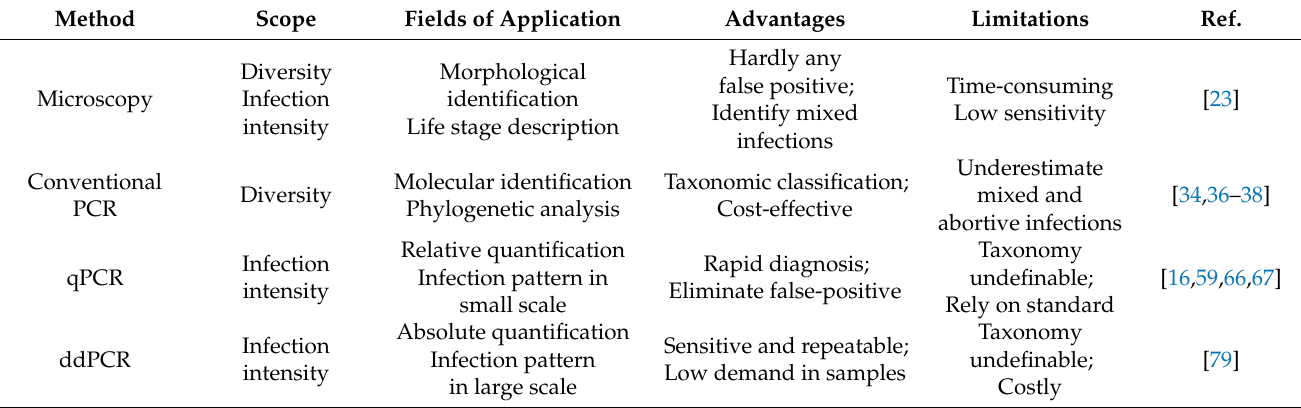
Table 2. Comparison of the most widely used methods in studying avian haemosporidian